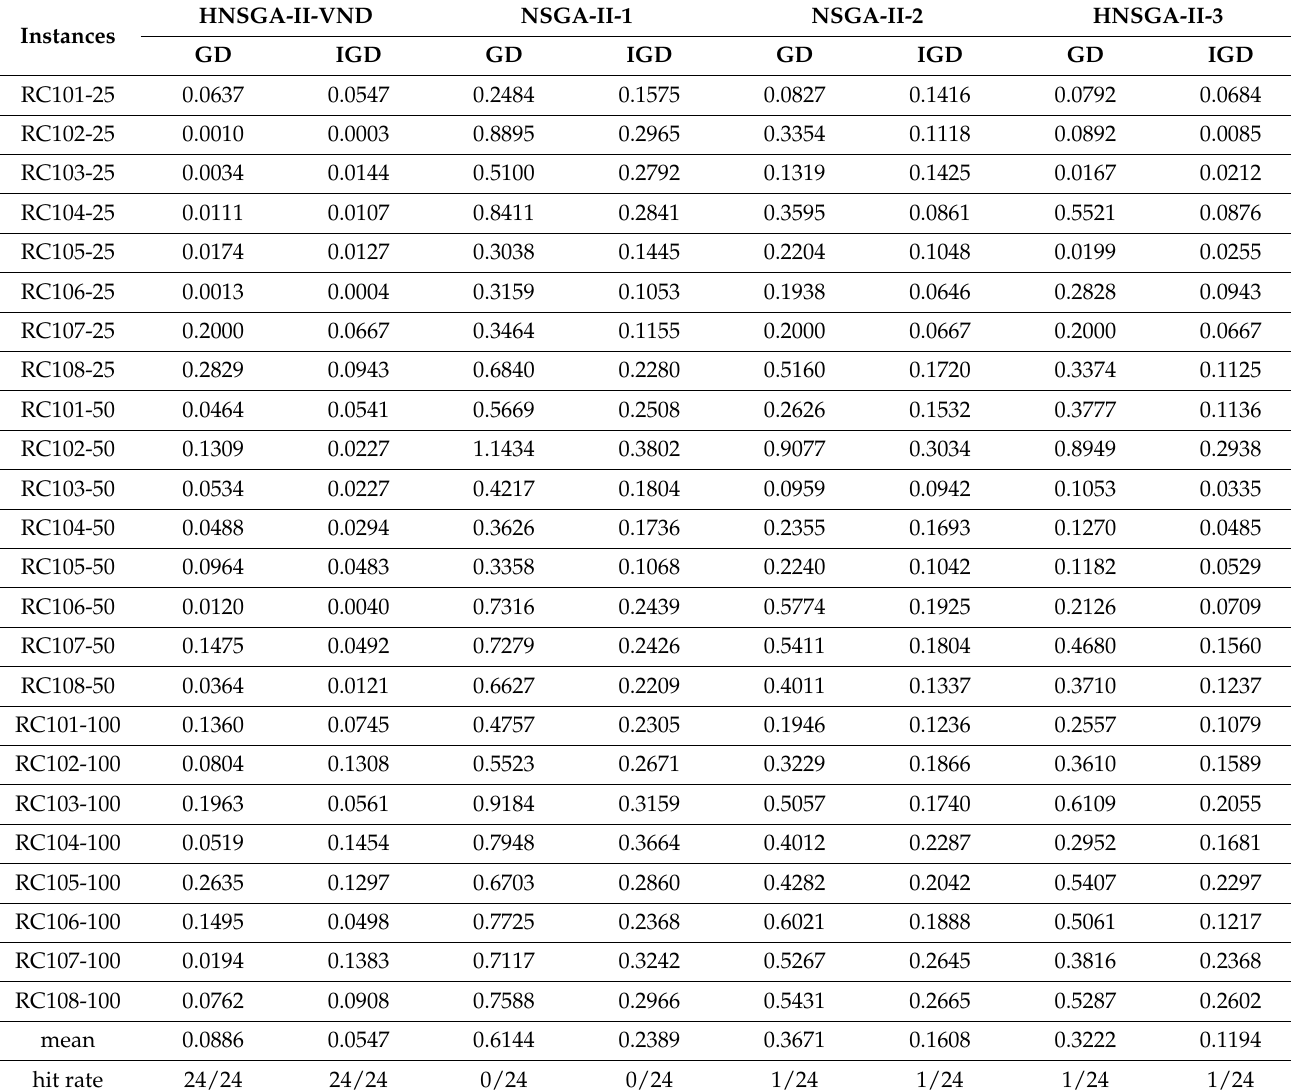
Table 4. The mean value of the metrics between HNSGA-II-VND and its variants in